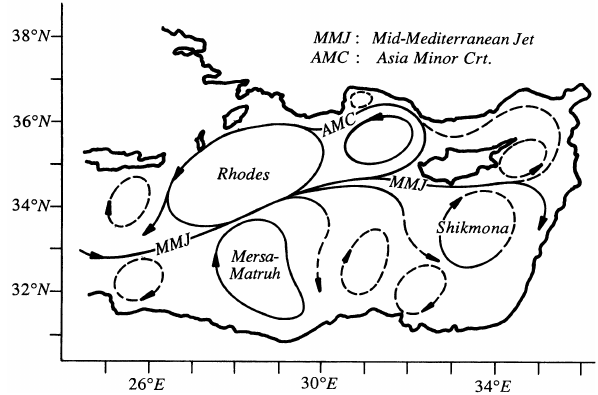
Fig. 12. Schematic upper thermocline general circulation (redrawn from Robinson et al.,